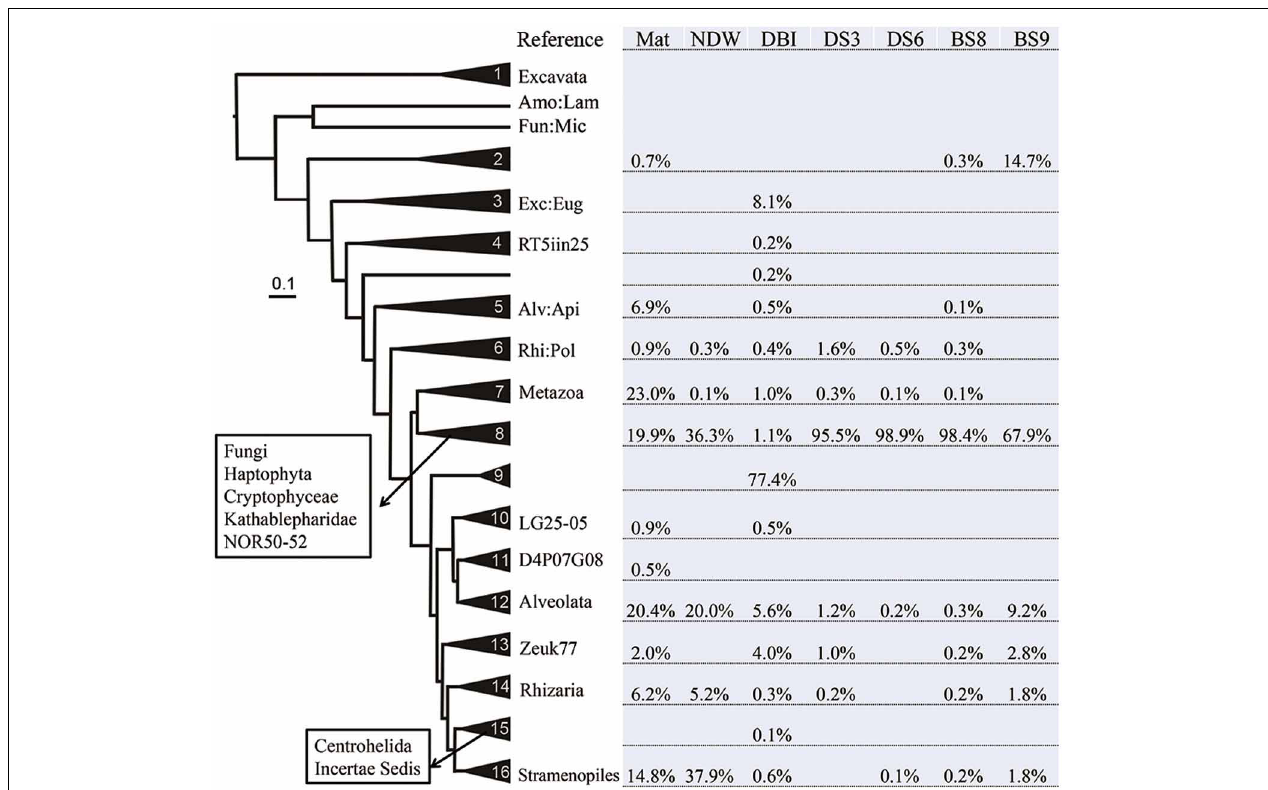
FIGURE 2 | Distribution of eukaryotic microbial communities in different clades of the Bayesian phylogenetic tree. The reference eukaryotic groups are labeled in reference to their 18S sequences. The sample IDs are defined in Table 1 . Lamproderma from Amoebozoa is abbreviated Amo:Lam;